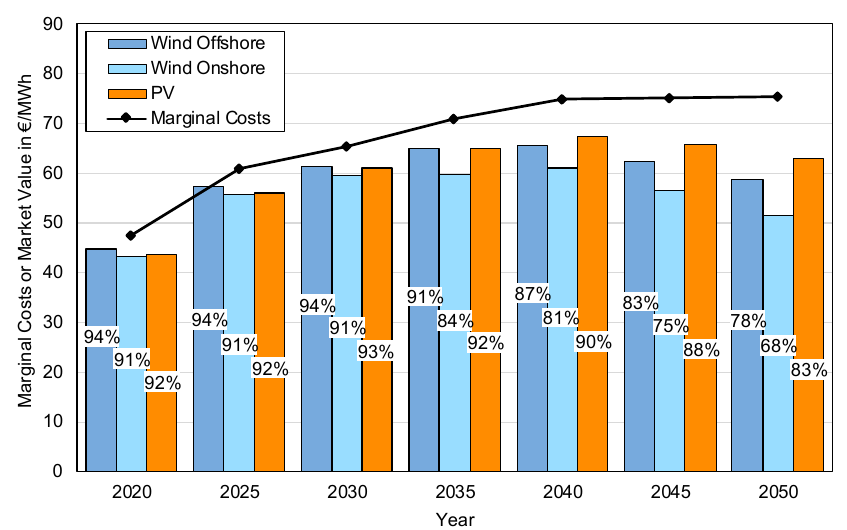
Figure 11. Marginal costs of electricity and market value of vRES (wind and photovoltaic (PV)) in €/MWh.